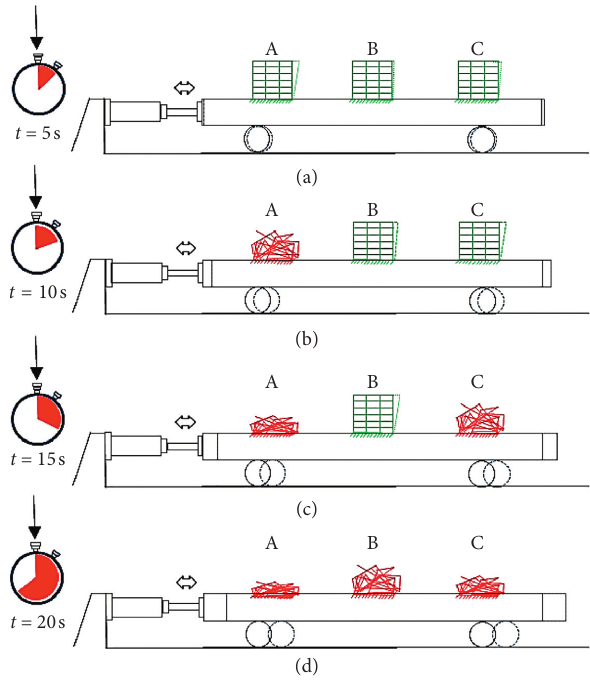
Figure 1: Hypothetical shaking table test.